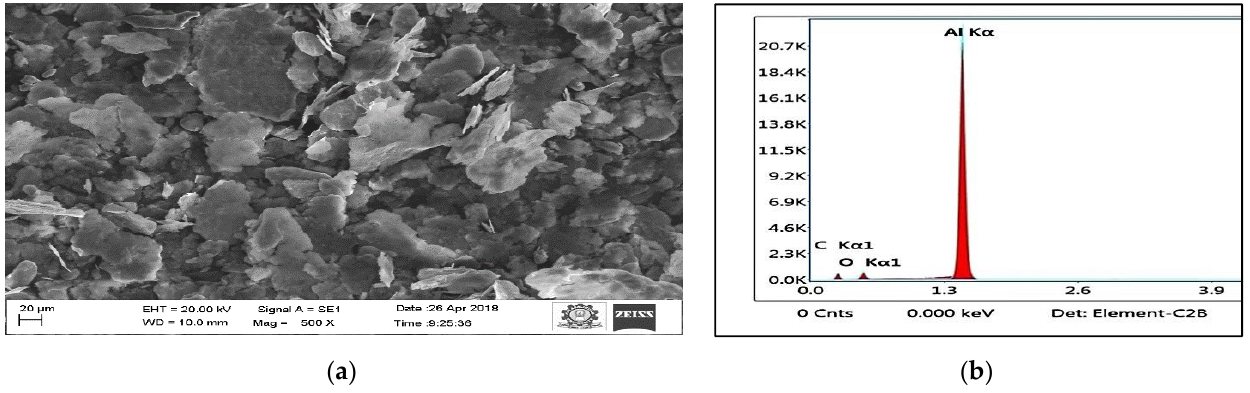
Figure 6. ( a ) SEM image of Aluminum Powder; ( b ) EDAX image of Aluminum Powder.